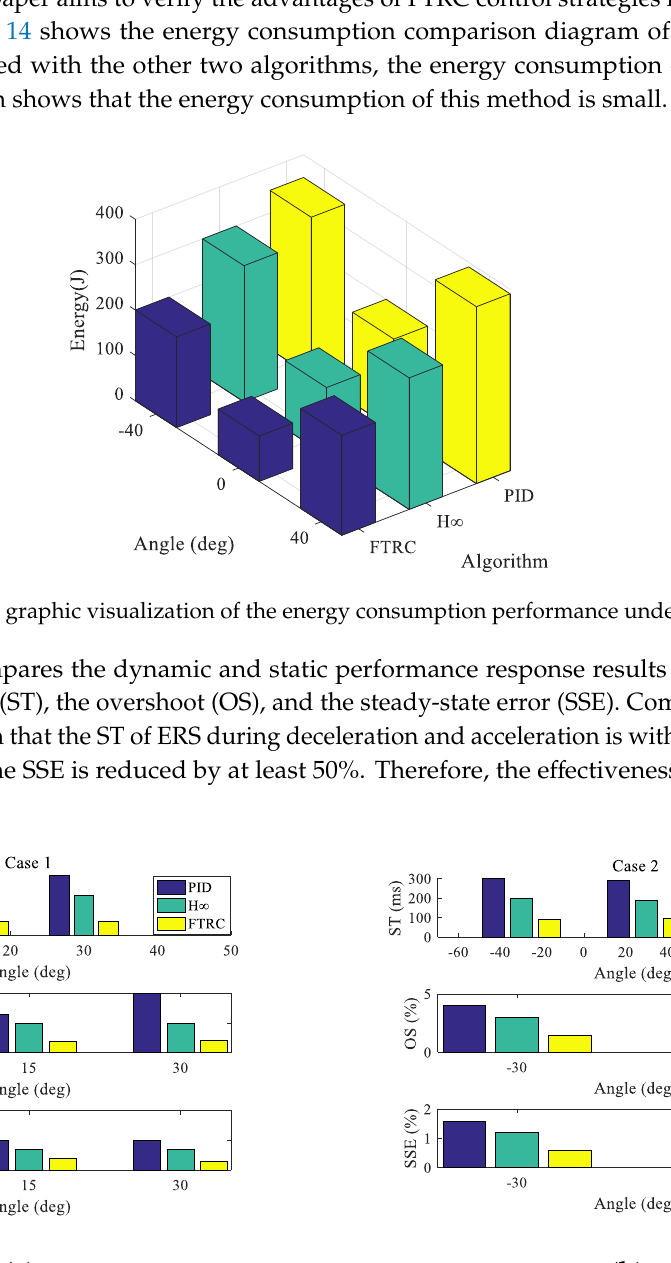
Figure 13. Actual response and error of different algorithm under input chirp signal: ( a ) system response; ( b ) system response error.